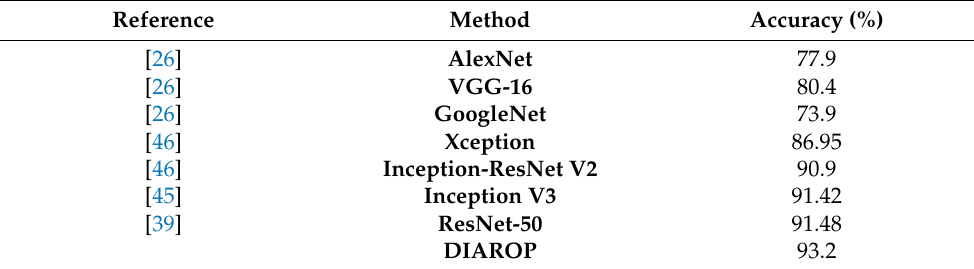
Table 9. A comparison between DIAROP and recent work based on the same